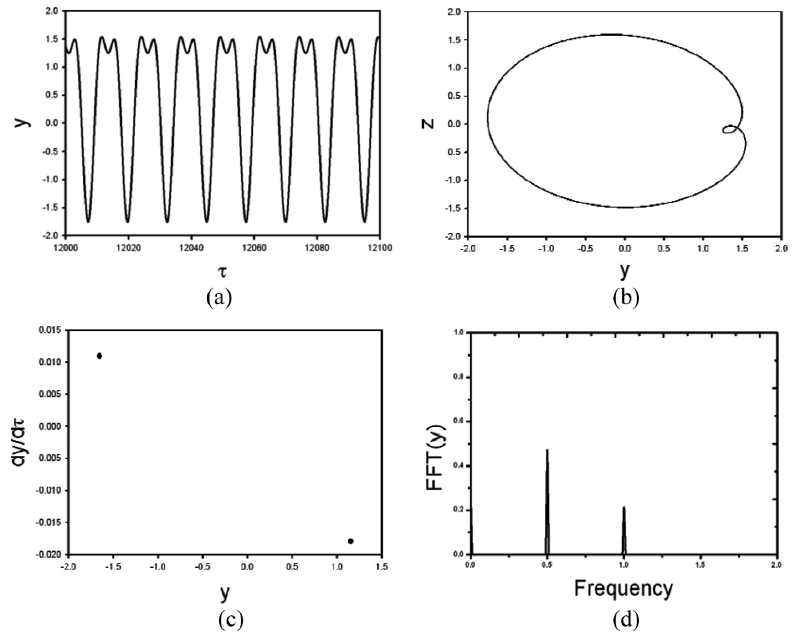
Fig. 11. Dynamic characteristic of the y-displacement of the mid-span point with ω = 680 rad/s. (a) Time history; (b) Orbital trajectory; (c) Poincar´e section; (d) FFT.